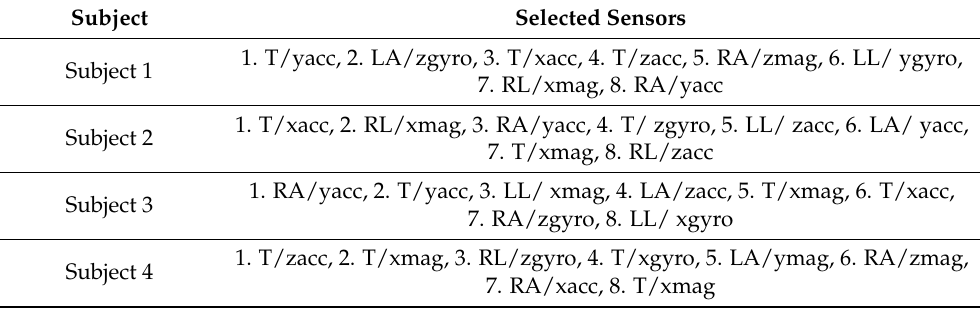
Table 5. Selection results of important sensors in DSAD based on complementarity measure.